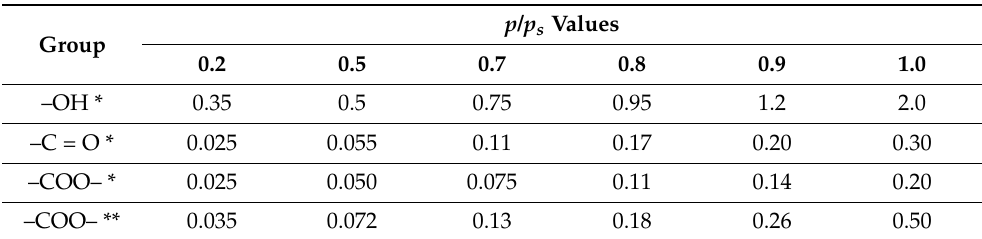
Table 5. Molar water content in cellulose esters per polar group at different moisture contents at 25 ◦ C.